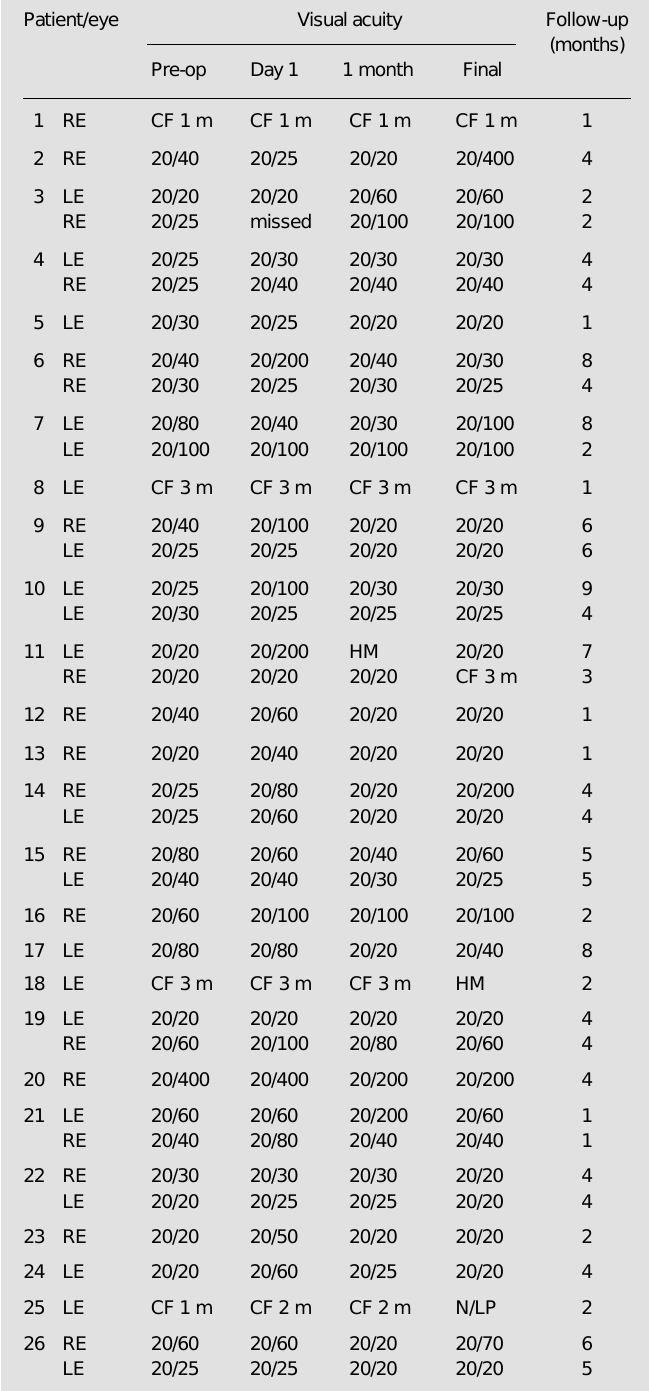
Table 2 - Patient, eye and pre-operative visual acuity, after 1 day, 1 month, final, and follow-up period (in months). For abbreviations, see legend to Table